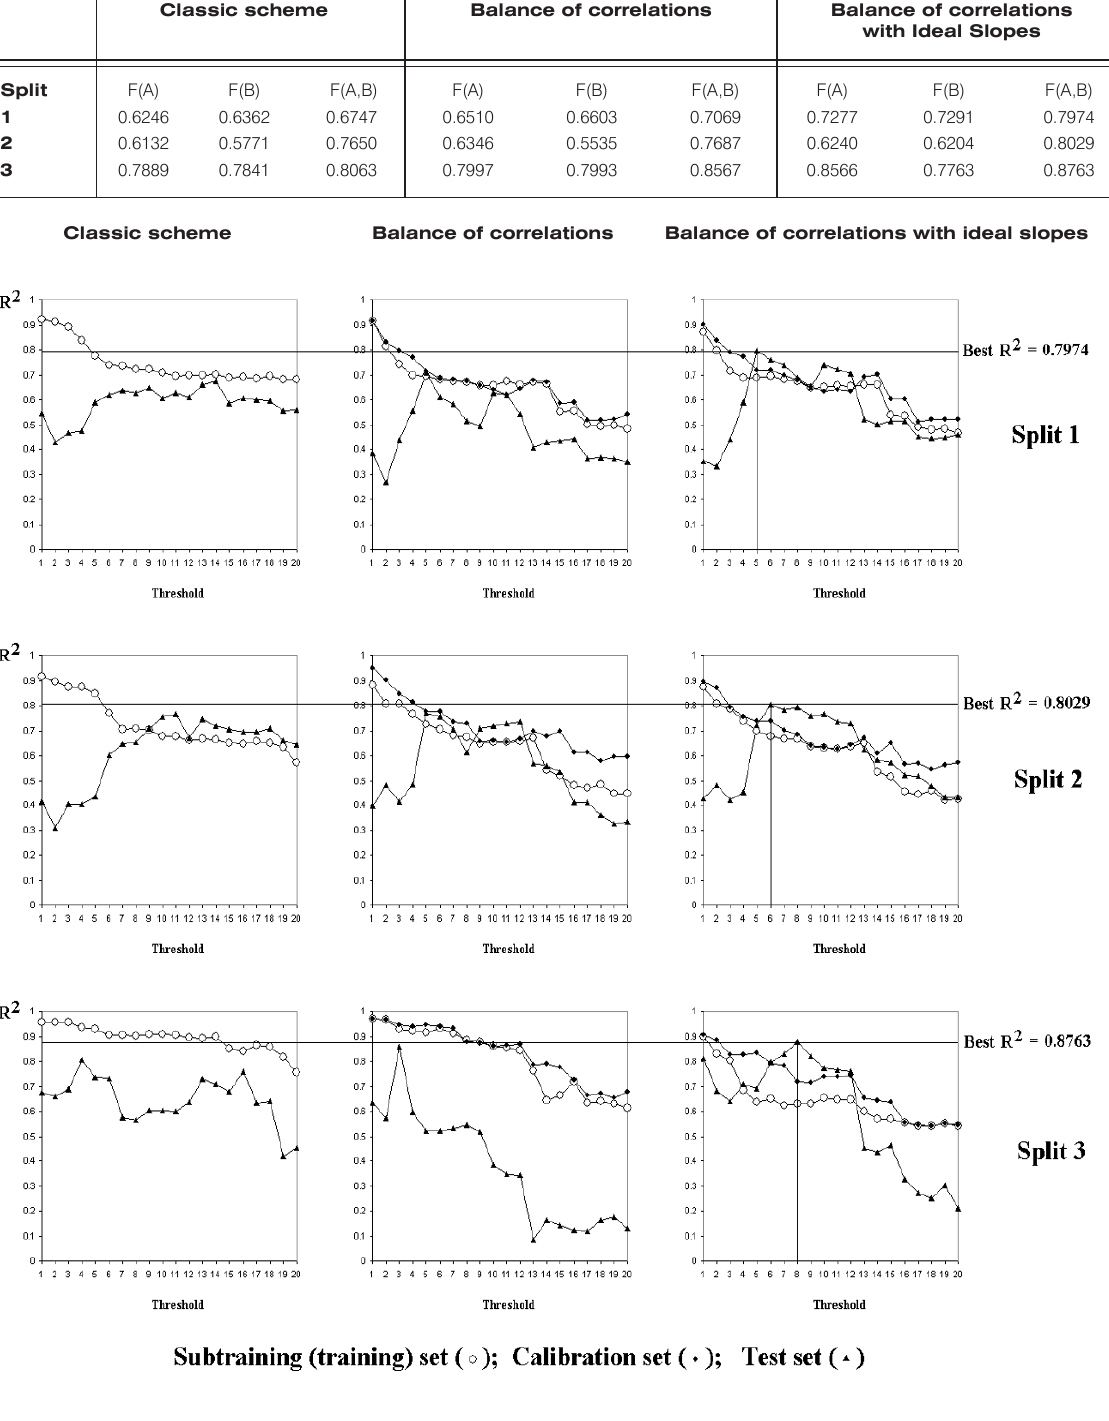
for the validation sets. The descriptors were 50